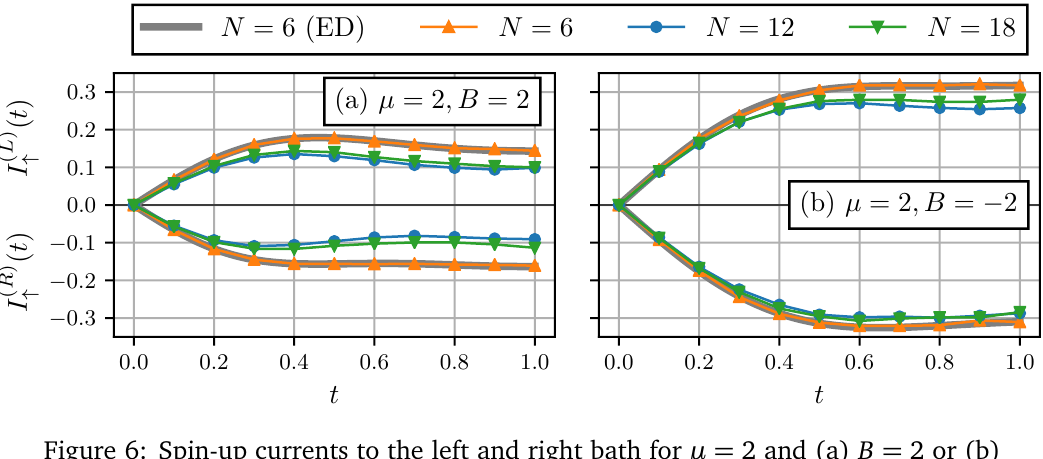
Figure 6: Spin-up currents to the left and right bath for µ = 2 and (a) B = 2 or (b) B = − 2. Fig. (a) can be understood as spin-down currents for B = − 2, just as Fig. (b) can be viewed as spin-down currents for B =